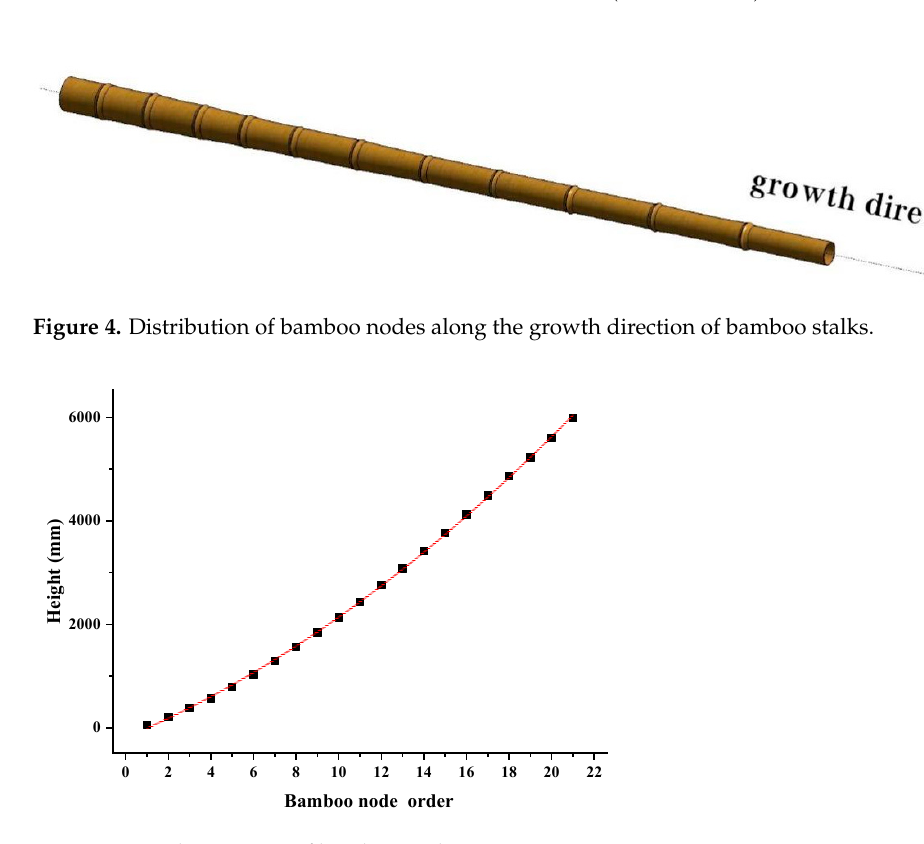
Figure 6. Statistics of the average moisture content of the specimens. 3.4. Influence of Bamboo Nodes on Bearing Capacity The results shown in Table 1 were obtained by statistical analysis of the bearing ca- pacity of the node and internode specimens with various mechanical properties. Accord- ing to Table 1, among all kinds of specimens, specimen UC has the highest bearing capac- ity, while specimen B has the lowest bearing capacity. The bearing capacity of the UC, CC and CT node specimens is higher than that of internode specimens. The bearing capacity